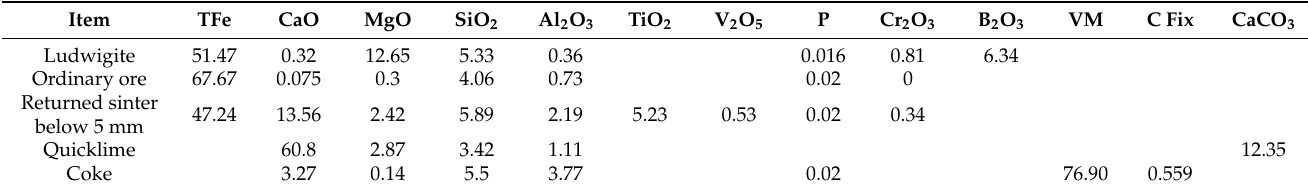
Table 1. Chemical composition of sintering materials/wt%.